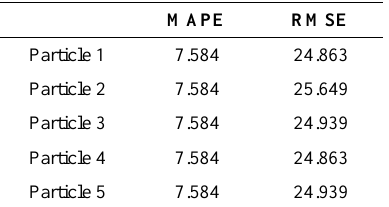
Table 24. MAPE and RMSE calculations in the last iteration MAPE